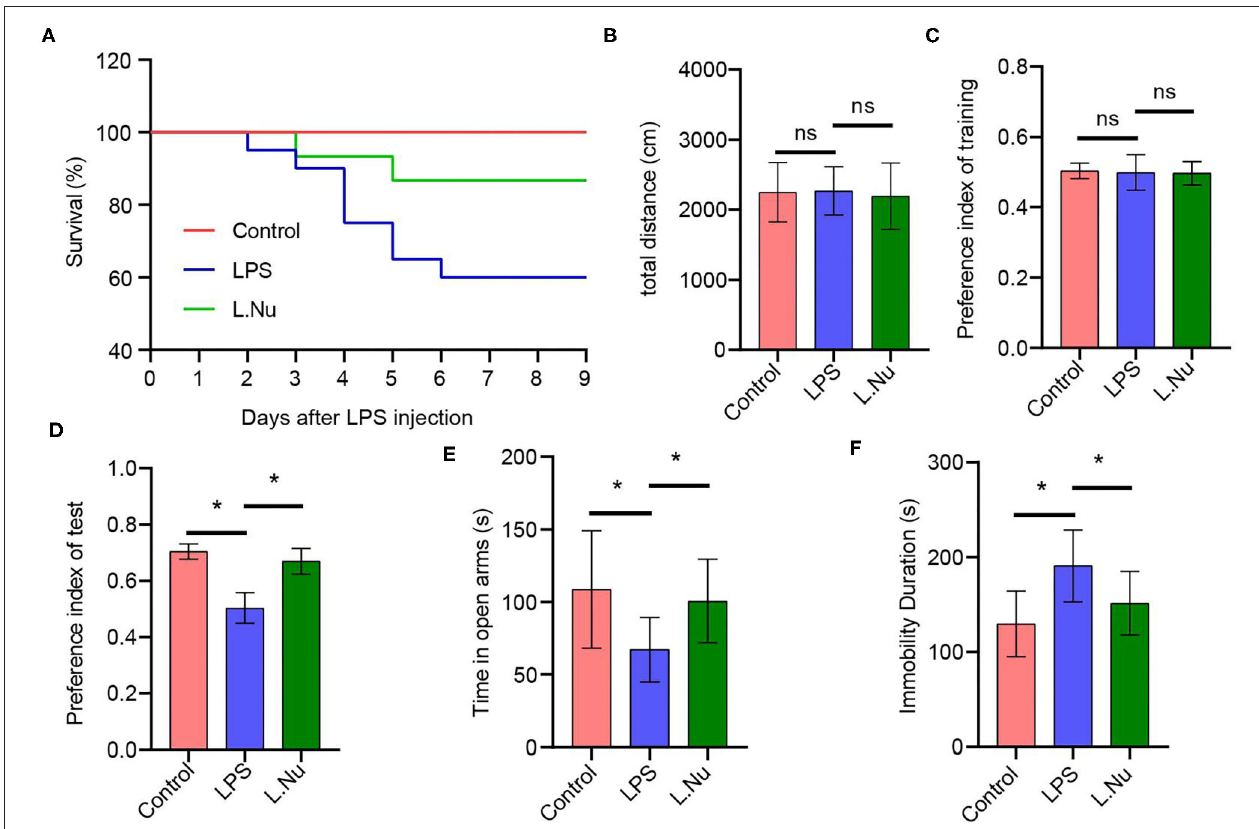
FIGURE 1 | NU9056 improved survival rate and relieved cognitive and emotional dysfunction in LPS-induced mice. (A) The 9-day survival rate of mice was determined. Twelve of twenty mice of the LPS group survived, 13 of 15 mice of the L. Nu group survived. (B) The total distance moved by each group of mice was detected in the OFT experiment. (C,D) The preference index of training and test were recorded in the NOR experiment. (E) The time in open arms was detected in the EPM assay. (F) The duration of immobility of the mice was analyzed using the TST experiment. * P < 0.05; ns, not significant; n = 8–20